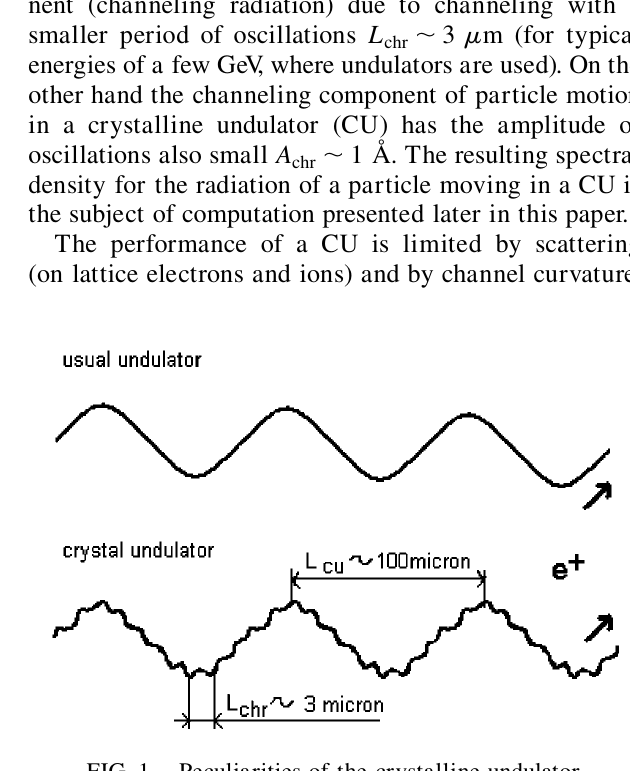
FIG. 1. Peculiarities of the crystalline undulator.*Email address: